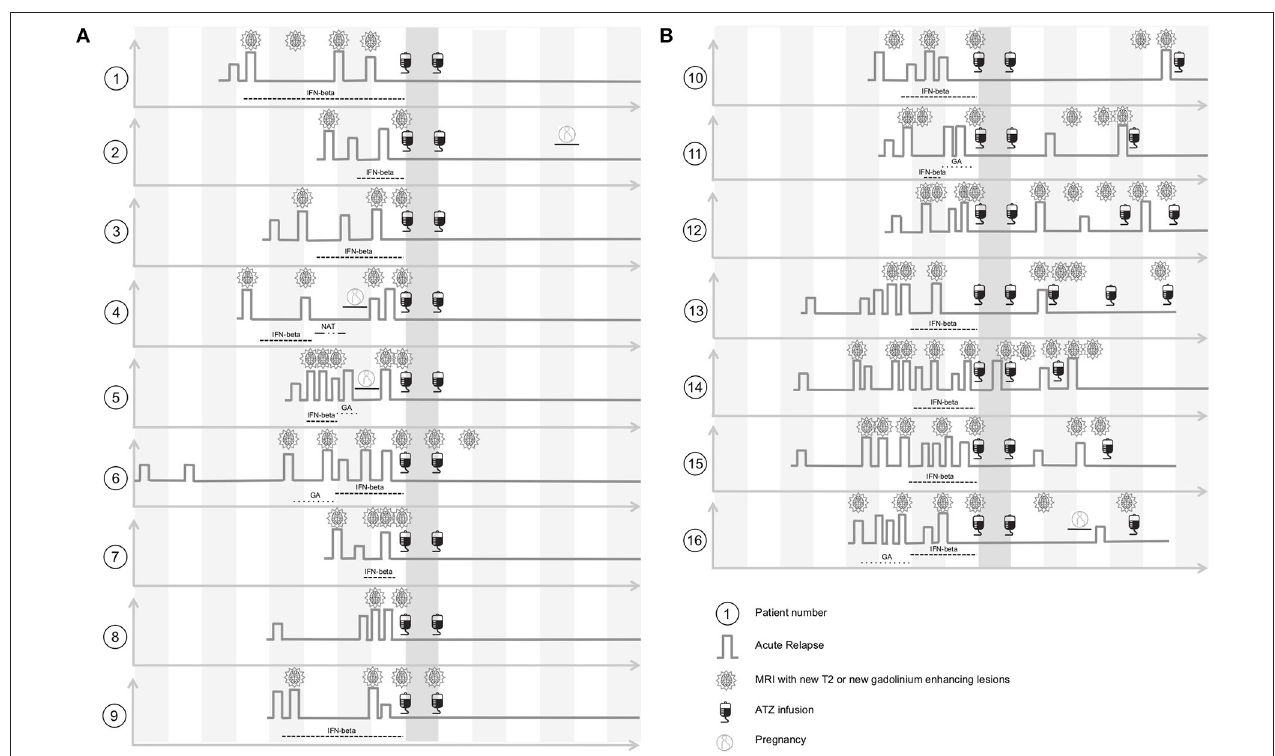
FIGURE 1 | Clinical characteristics of ATZ treated patients before and after ATZ infusion. (A) ATZ treated patients without ATZ retreatment are depicted (complete-responder, patient 1–9). Clinical disease course including pre-treatment, relapse activity and MRI progress within yearly MRI scans before and after ATZ infusion are shown threw yearly time intervals. After ATZ infusion, follow up evaluation up to 7 years are presented. (B) ATZ treated patients that were retreated with ATZ additionally to two standard ATZ treatments are depicted (partial-responder, patient 10–16). Clinical disease course including pre-treatment, relapse activity and MRI progress within yearly MRI scans before and after ATZ infusion and intervals of ATZ retreatment are shown threw yearly time intervals. After ATZ infusion, follow up evaluation up to 7 years are presented. GA, glatiramer acetate; IFN-beta, interferon-beta; NAT,